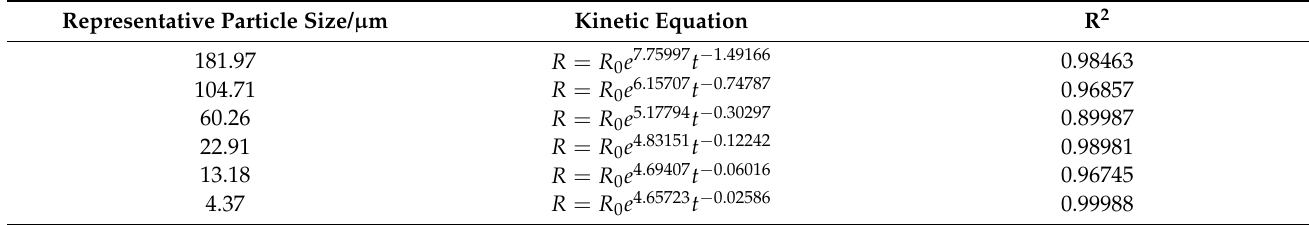
Figure 5. Fitting curve of sieve allowance and grinding time of representative particle size of CGS. Table 3. Grinding kinetic equation of representative particle size of CGS.